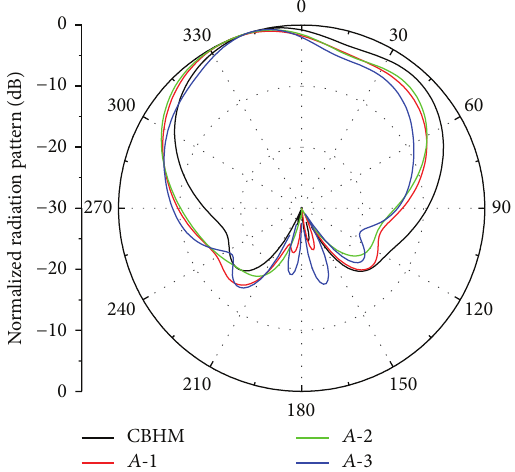
Figure 22: Graphics of |𝑆 21 | : collinear configuration.